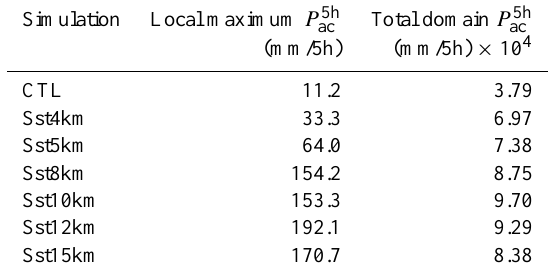
Table 2. Local maximum and domain total of P 5h ac field in simula- tions with different small-scale terrain